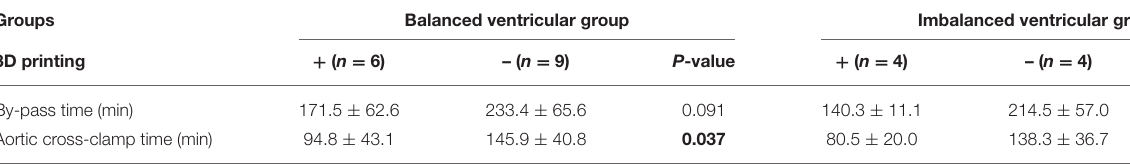
TABLE 2 | Surgery time of patients with and without 3D printing in two groups. Groups